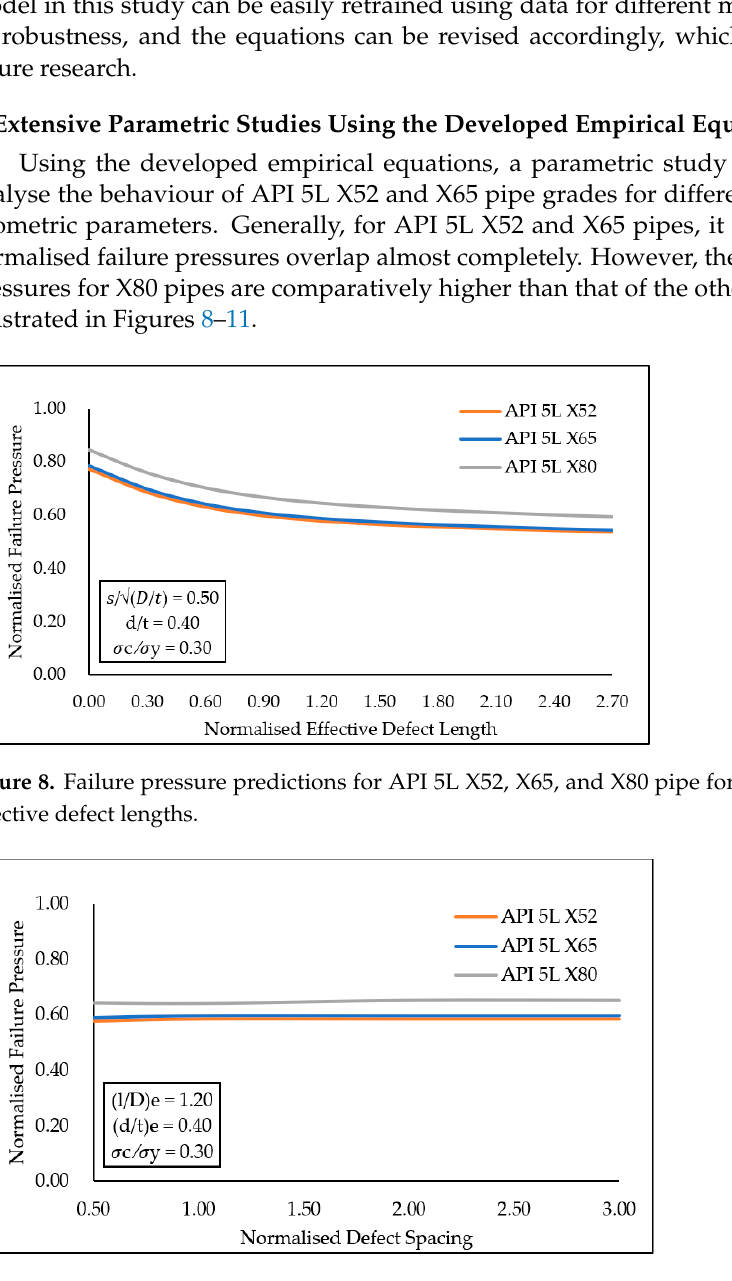
Figure 9. Failure pressure predictions for API 5L X52, X65, and X80 pipe for multiple normalised defect spacings.